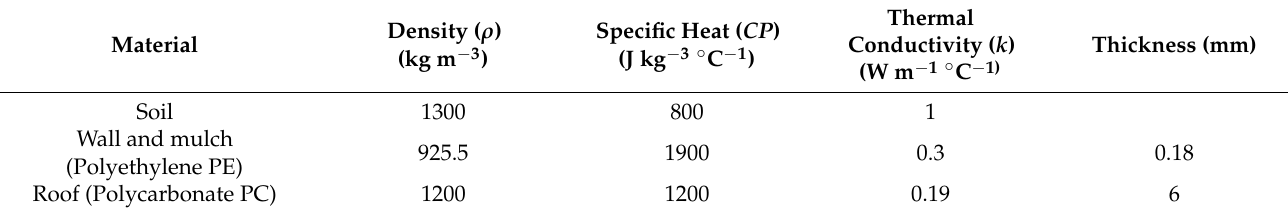
Table 1. Properties of cladding materials.